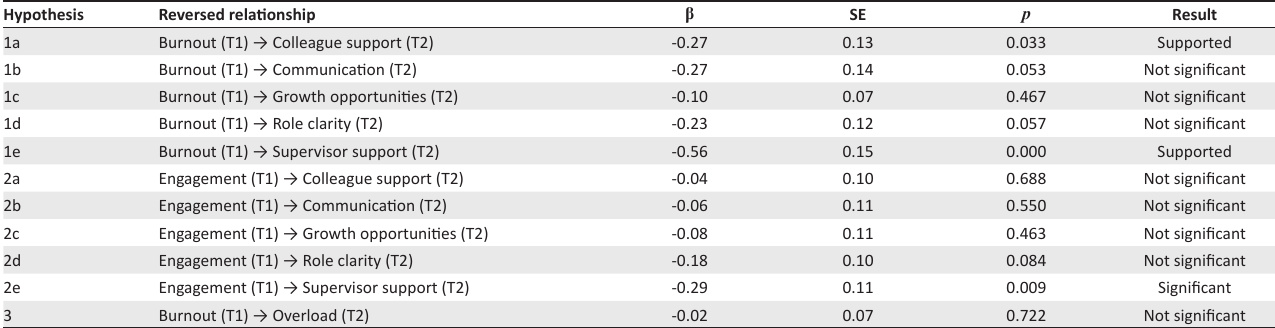
TABLE 4: Hypotheses summary with relevant statistics and results reported. Hypothesis